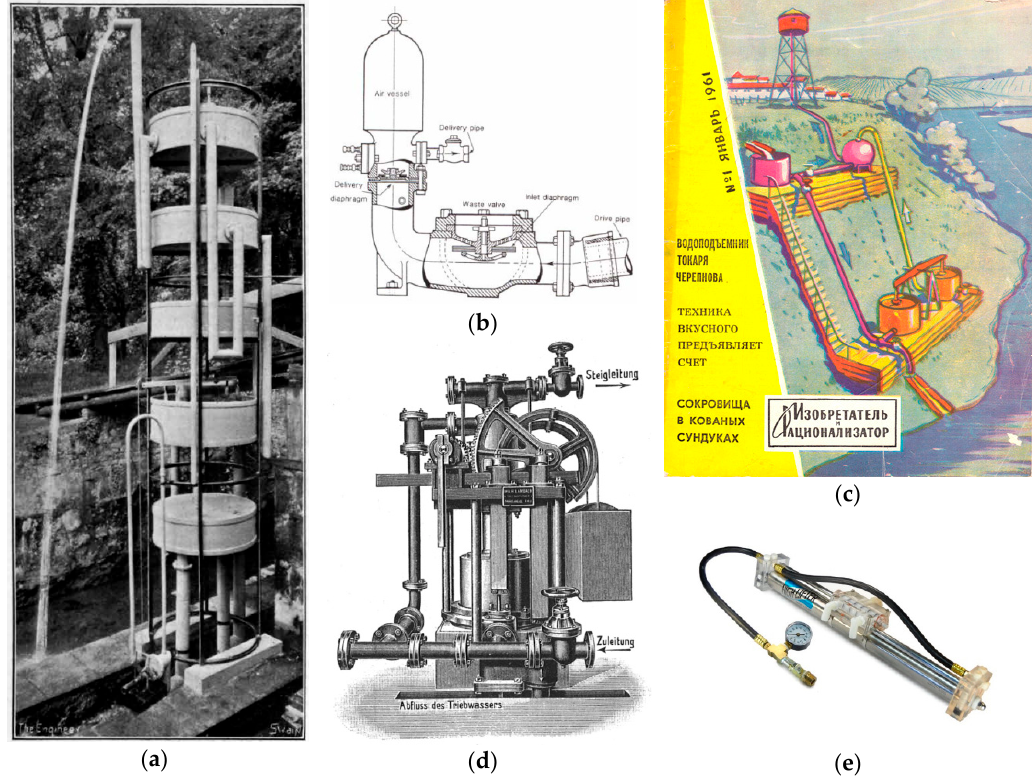
Figure 3. Different types of hydro ‐ pneumatic water lifters: ( a ) Hydrautomat [77]. © Grace’s